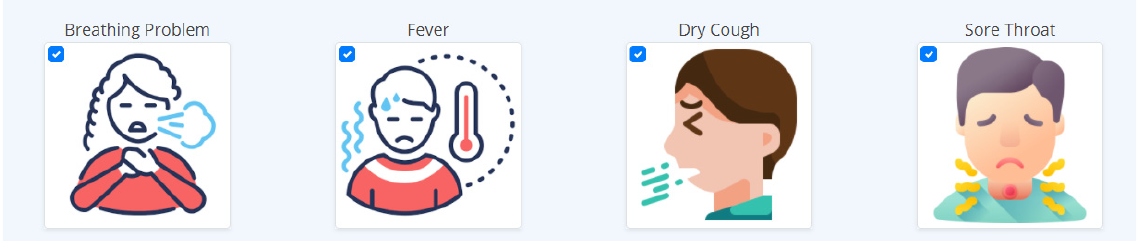
Figure 11. The activated checkbox of the selected symptoms.